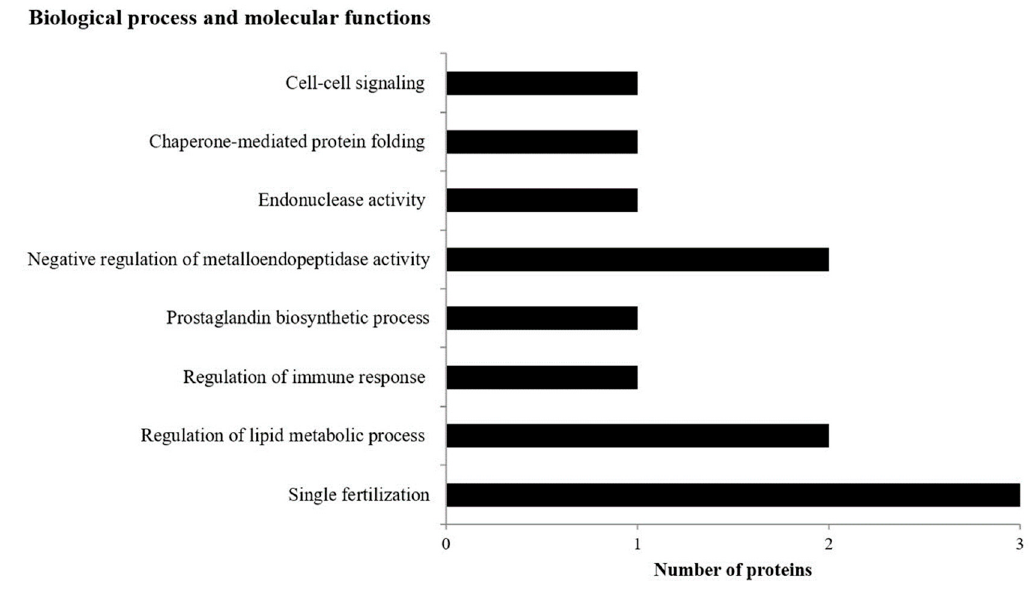
Figure 4. A graph representing number of identified proteins in supernatant from young and adult bulls involved in different biological processes and molecular functions. All of the proteins were increasing in abundance in adult bulls in comparison to young bulls.